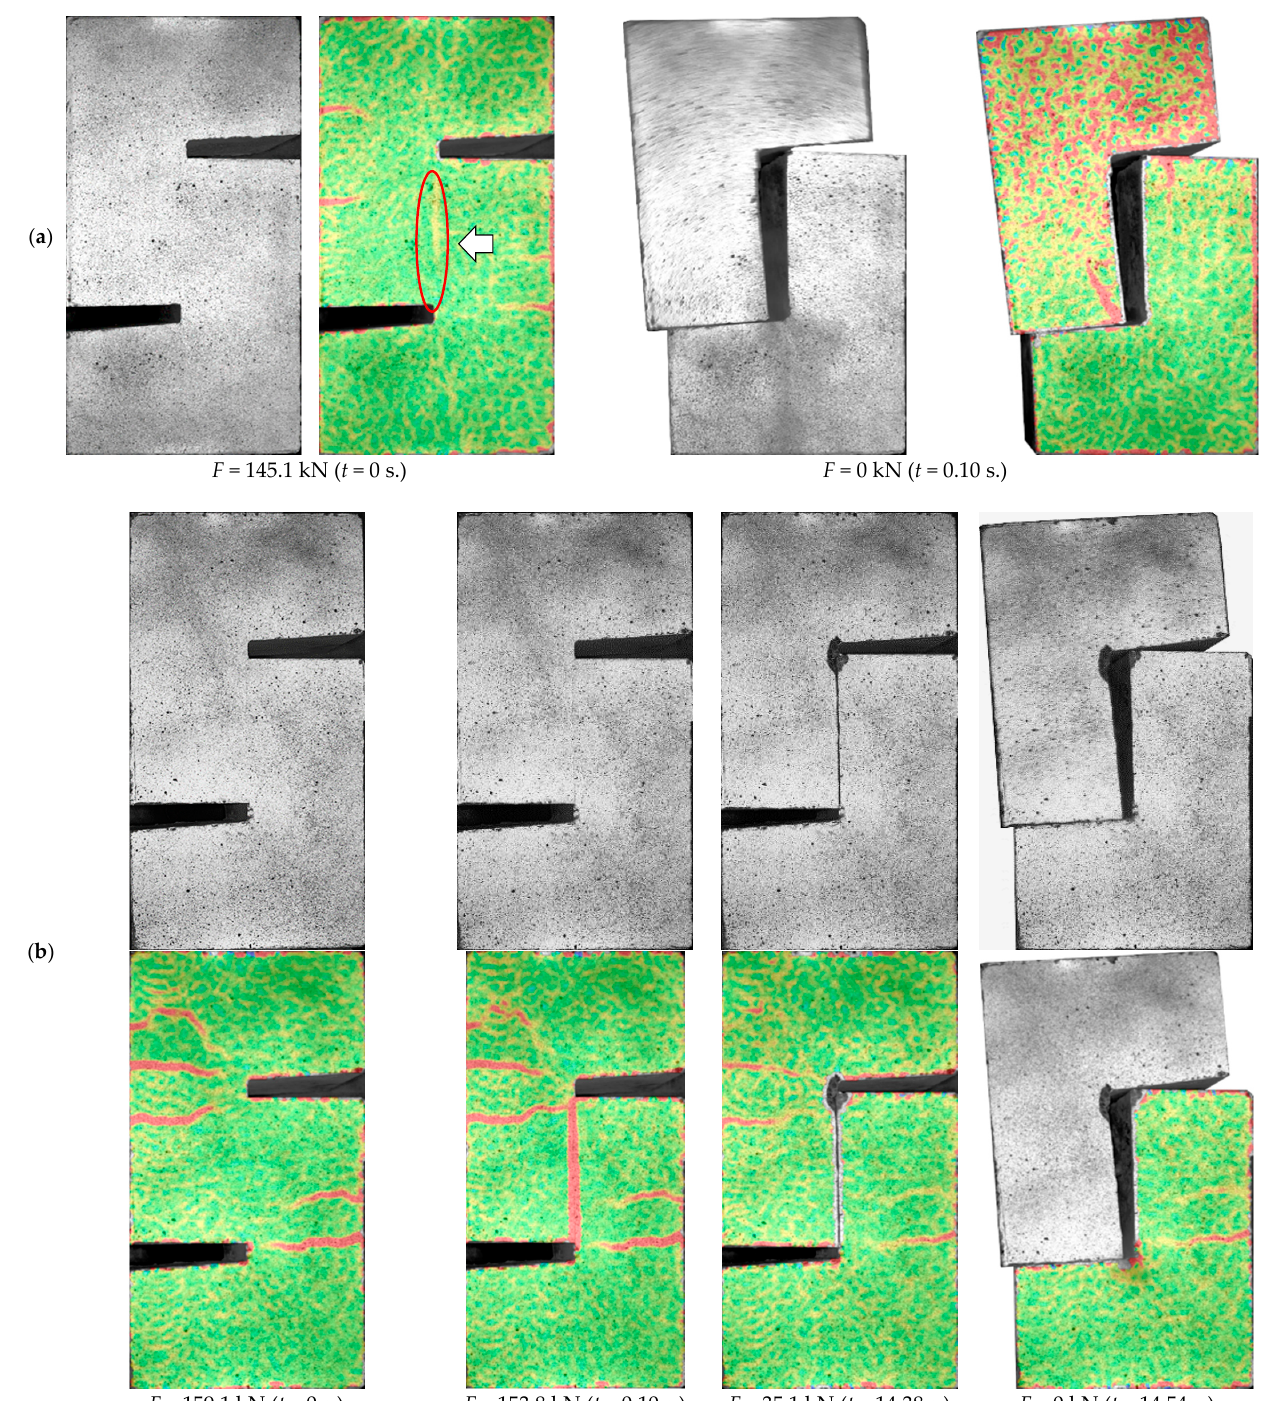
Figure 10. View of the surface of: ( a ) L30/50-S-0, ( b ) L30/50-S-0.14—crack formation at subsequent load levels and major strains (values in parentheses indicate the time measured from the moment of reaching the maximum load). Cracks at the interface were registered at higher loads levels. In case of the specimens without shear reinforcement occurrence of the interface crack was synonymous with exhaustion of load carrying capacity because within fractions of a second (~0.1 s), failure manifested with a rapid detachment of the concrete block was observed. An example of the crack development and destruction process of L30/50-S-0 model, typical for specimens without shear reinforcement, was presented in Figure